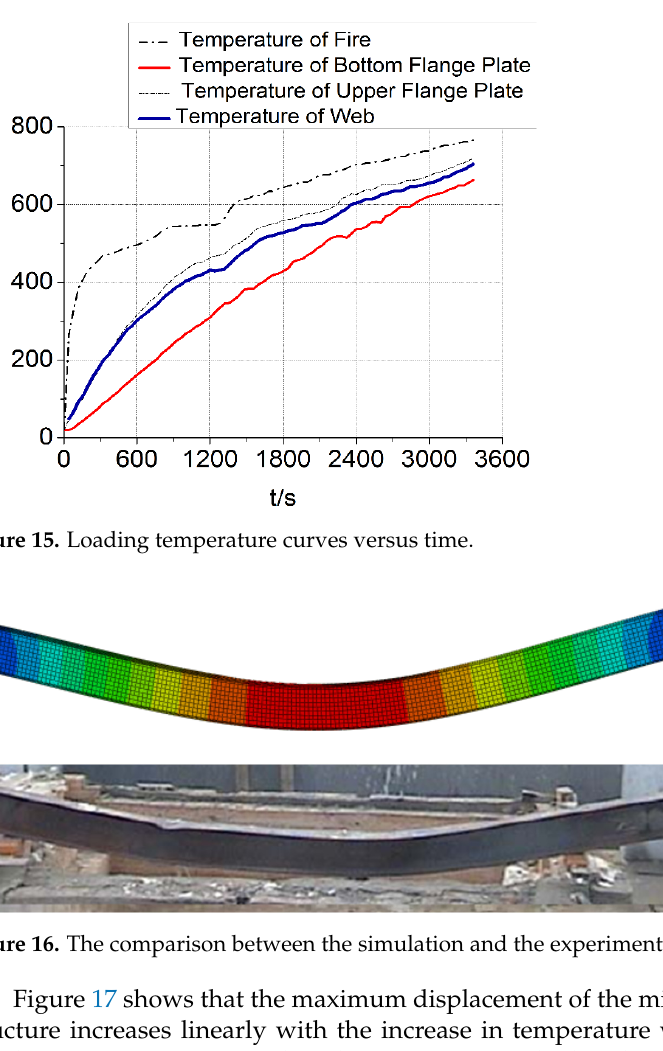
Figure 14. Schematic diagram of beam loading .